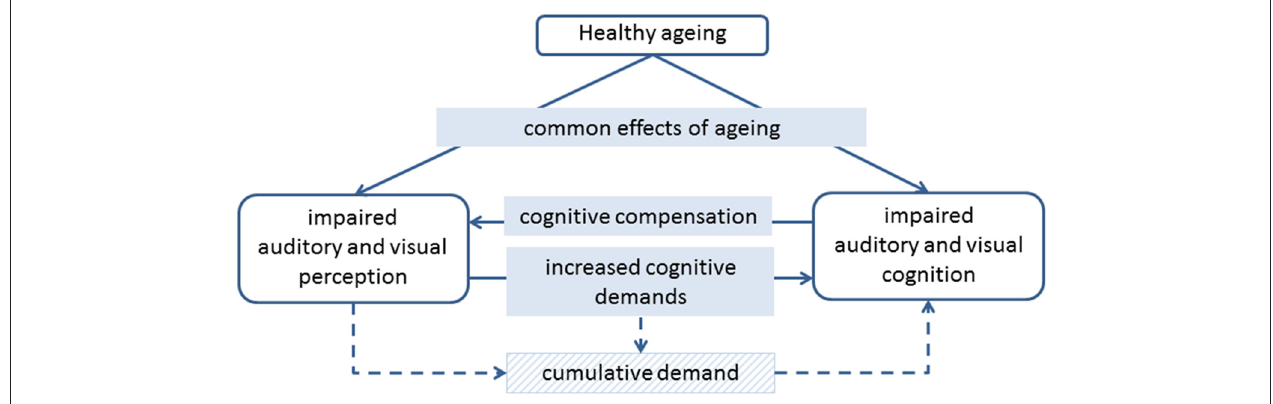
FIGURE 1 | Diagram of the potential links between healthy ageing, auditory and visual perception, and auditory and visual cognition.